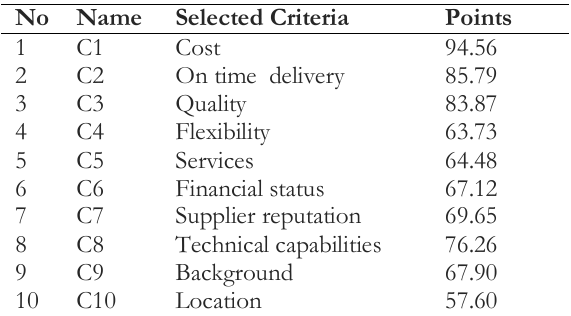
Table 4. Selected